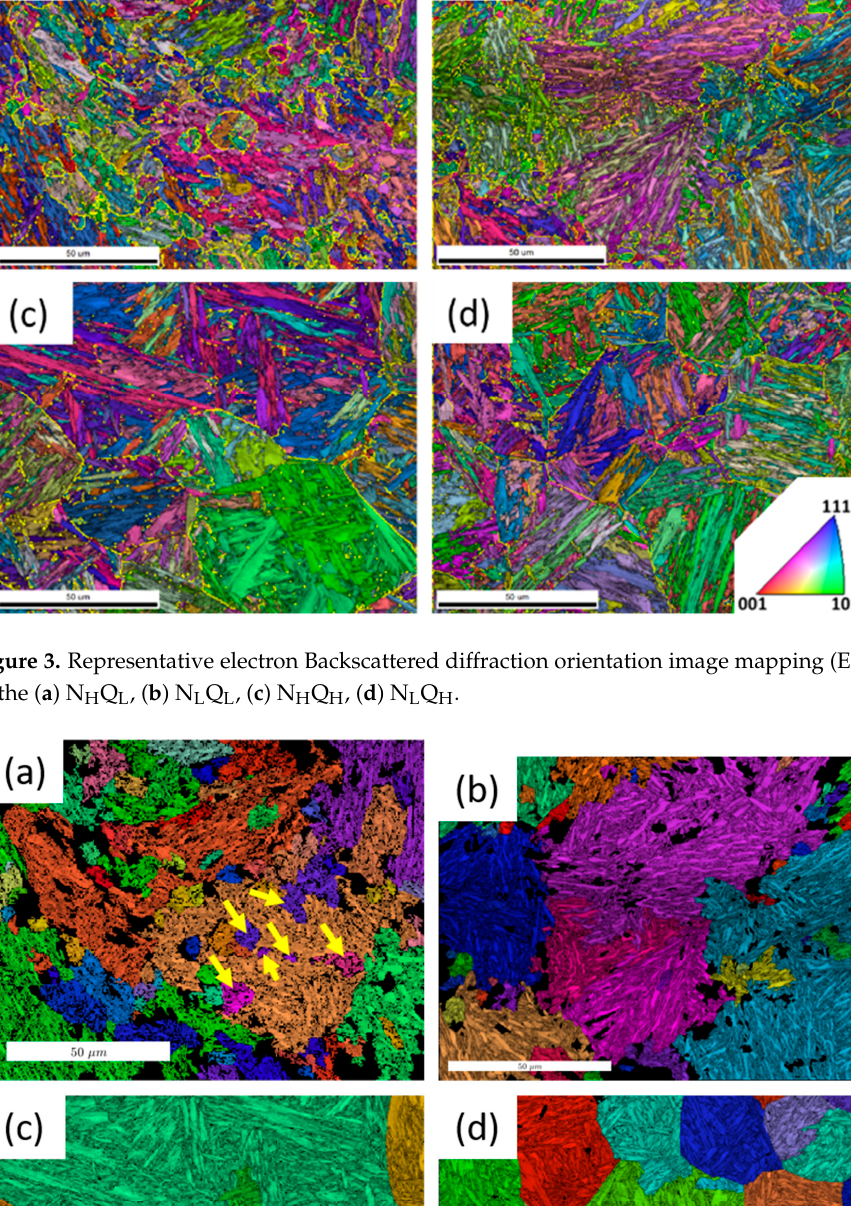
Figure 5. Kernel Average Misorientation of the N H Q L showing regions of recrystallized α -ferrite shown in blue.